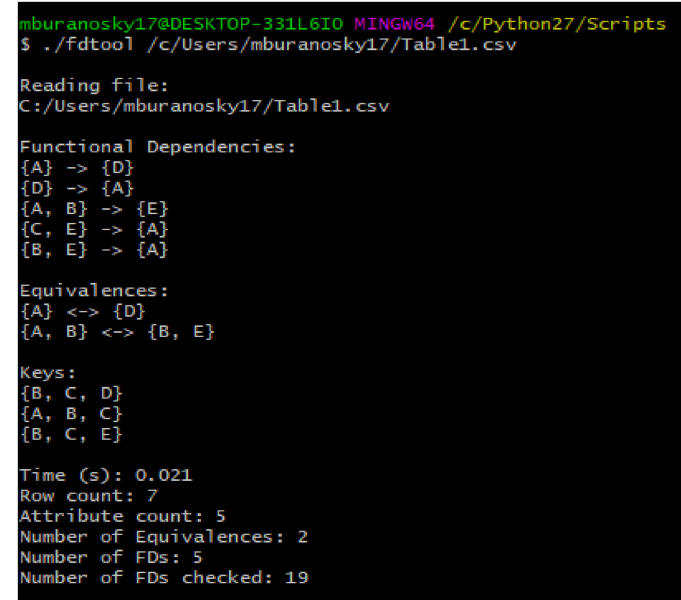
Figure 3. Printed output of FDTool.exe.